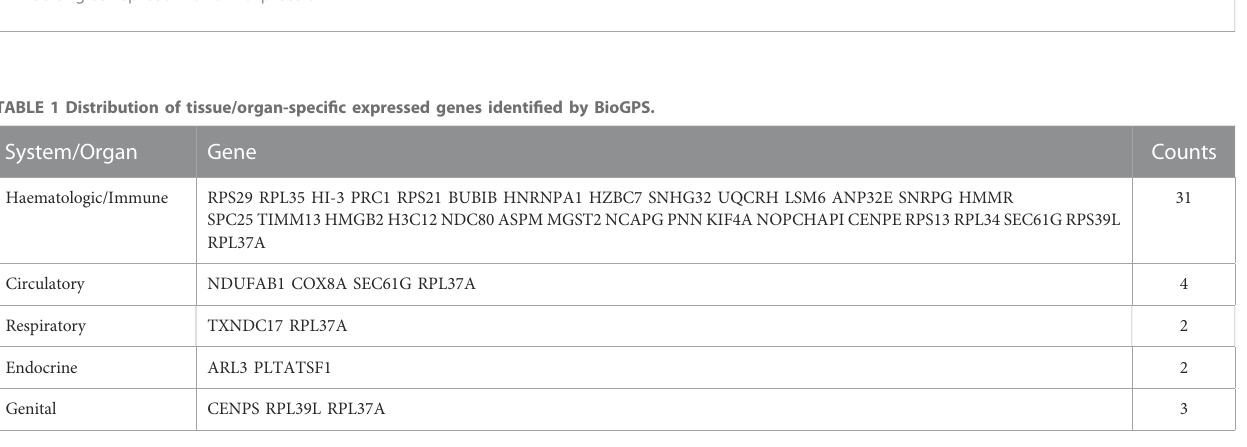
FIGURE 1 Normal samples and RA samples (A) volcano plot of the 113 DEGs, The red dots represent upregulated genes, and the blue dots represent downregulated genes. (B) Heatmap of 40 DEGs between the RA samples and the OA samples. Red rectangles represent high expression, and blue rectangles represent a low expression.